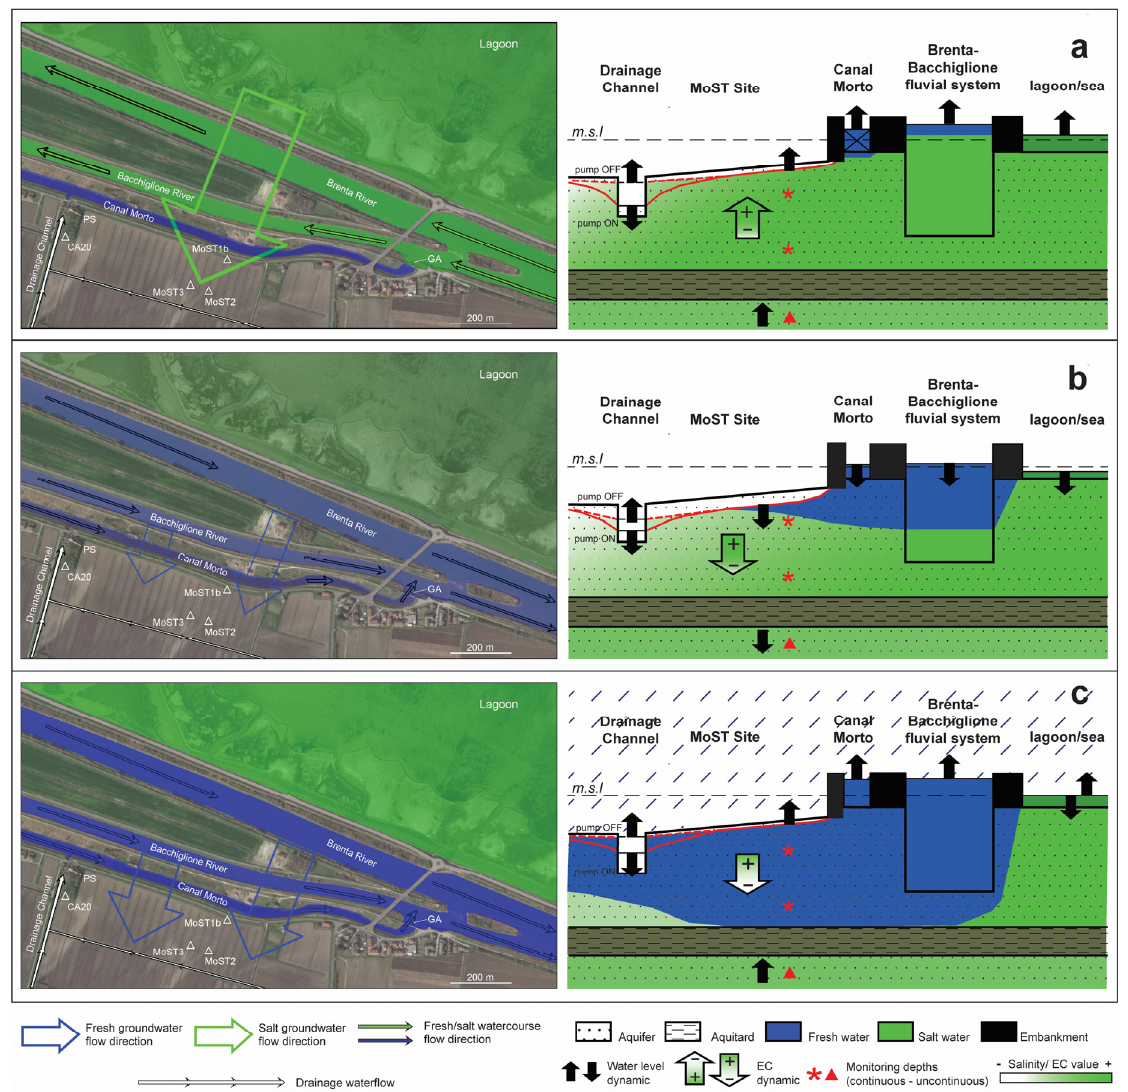
Figure 15. Schematic representation of the SWI and freshwater pathways, obtained over the monitoring period July–October 2020, in three different scenarios: ( a ) dry periods with high tide and CM gate closed; ( b ) dry periods with low tide and CM gate opened; and ( c ) wet periods with heavy precipitations (regardless of high or low tide and gate closed or